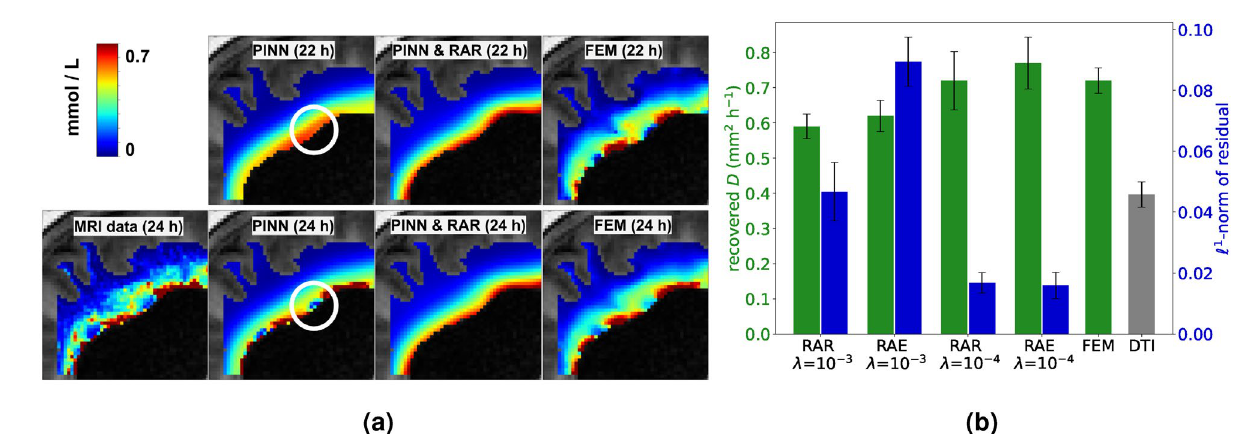
Figure 6. Adaptive refinement yields PINN solutions that are consistent with a diffusion model. ( a ) Upper row: Output c ( x , t = 22h, θ opt ) of PINNs models trained with p = 1 and p = 1 & RAR and FEM solution for (α , β , γ) = ( 10 − 6 , 0.1, 0.01 ) . Lower row: Zoom into a sagittal slice of data at 24 h compared PINN and FEM solutions. The PINN prediction after training without RAR overfits the data. Compare also to Fig. 5. ( b ) Green: PINN estimates for the diffusion coefficient with RAR or RAE and different initial learning rates ( p = 1 in all cases). Blue: ℓ 1 -norm of the residual after training. It can be seen that lower learning rate leads to a lower residual norm and an estimate for the diffusion coefficient closer to the FEM